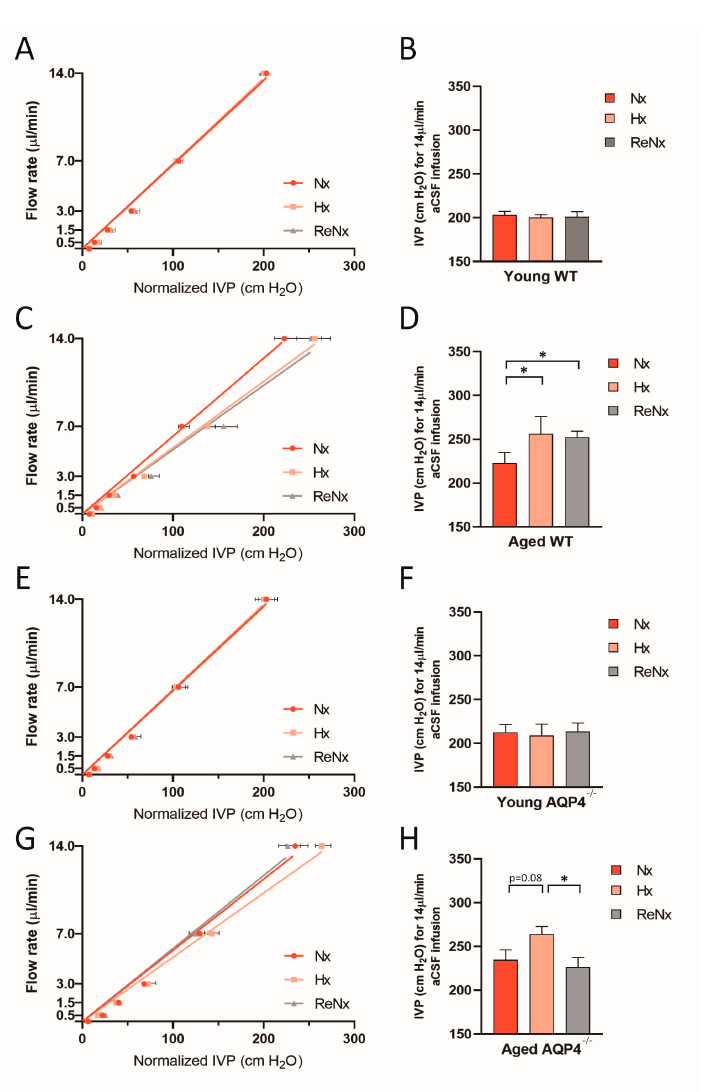
Figure 3. Hypoxia induces a permanent deterioration of CSF drainage capacity in aged wt mice. The figures represent the linear regression obtained for the relationship between the infused artificial CSF rate and the IVP reached in a stationary state, for each experimental group: ( A , B ) young wt, ( C , D ) aged wt, ( E , F ) young AQP4 − / − , ( G , H ) aged AQP4 − / − , under the experimental conditions indicated (Nx: normoxia; Hx: hypoxia; ReNx: re-normoxia). The normalized IVP was calculated by the subtraction of the basal IVP value (obtained without aCSF infusion) from the IVP values obtained after aCSF infusion at each rate. The bar graphs show the comparative analysis of the IVPs achieved for an infusion rate of 14 µ L/min for the different experimental groups. Data are represented as the mean ± SEM. Number of animals analyzed for each experimental condition: Young-wt, Nx ( n = 12); Hx ( n = 7); ReNx ( n = 6). Aged-wt, Nx ( n = 8); Hx ( n = 7); ReNx ( n = 5). Young-AQP4 − / − , Nx ( n = 10); Hx ( n = 8); ReNx ( n = 8). Aged-AQP4 − / − , Nx ( n = 8); Hx ( n = 6); ReNx ( n = 8). * p <